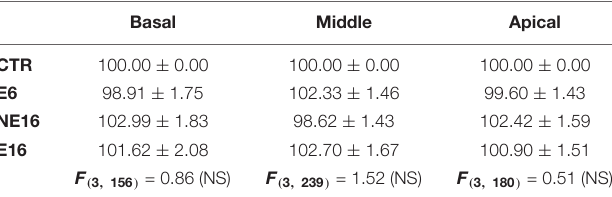
TABLE 6 | Mean, SE, and ANOVA analysis of the interaction between age, noise over exposure and cross-sectional areas of spiral ganglion cells in the cochlea relative to the control